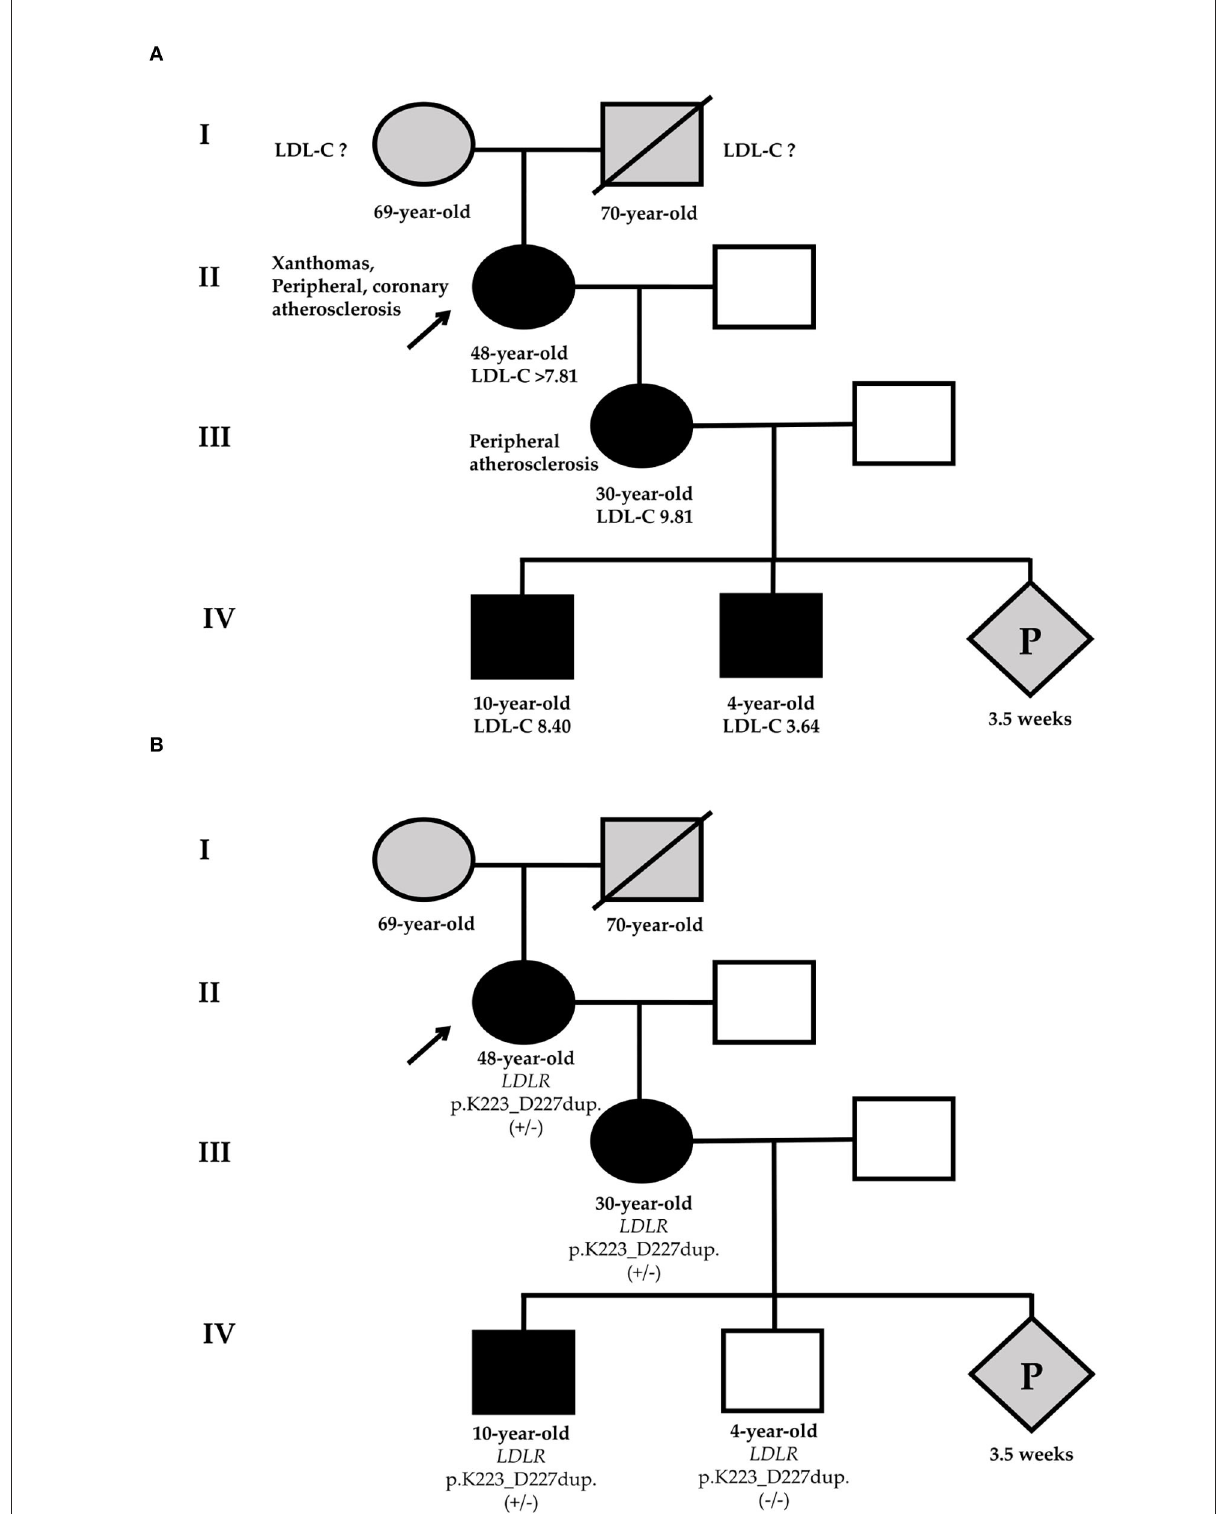
FIGURE1 Phenotypic (A) and genetic (B) cascade screening. According to phenotypic screening, the younger grandson has HeFH [black-filled square (A) ], in relation to genetic screening, he is healthy [white square (B) ]. Circles represent females, squares indicate males, and diamond is pregnancy (unknown gender). Black-filled symbols show FH phenotype, gray symbols point to members with an unknown phenotype, and white symbols are healthy family members. Slashes indicate deceased members. + /– or -/- represent heterozygous or wild-type of LDLR -p.K223_D227dup variant. The index patient (II-1) is marked with an arrow. LDL-C, low-density lipoprotein cholesterol; P,